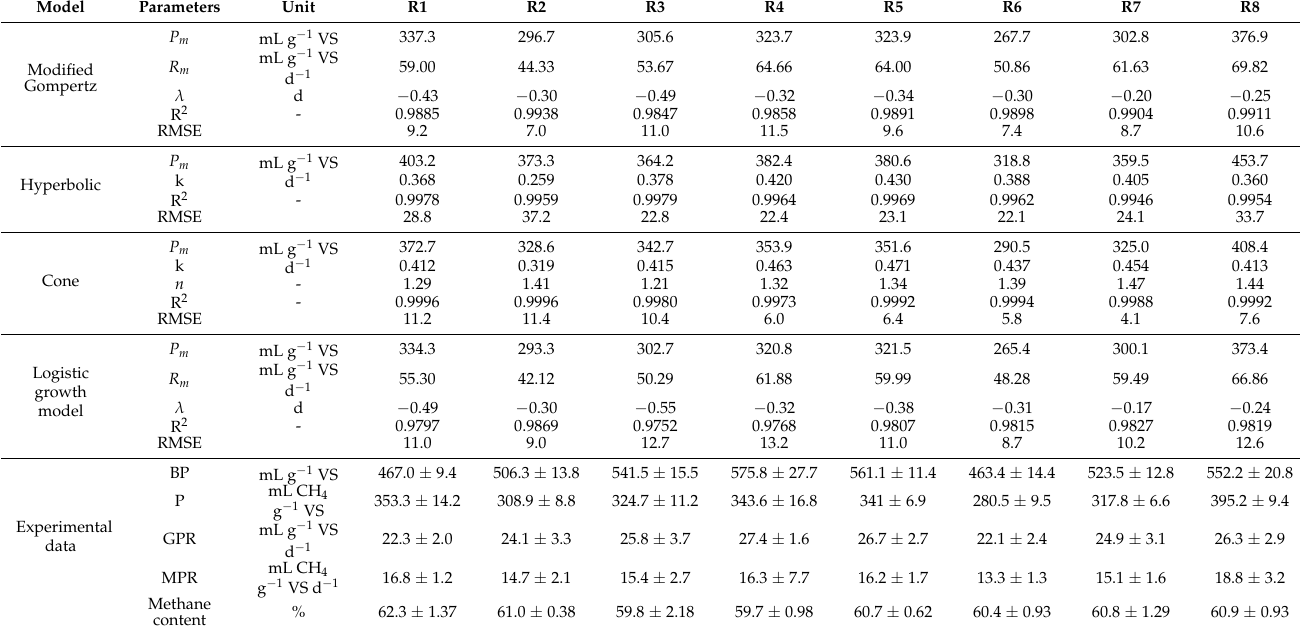
Table 4. The results of experimental data in terms of biogas/methane productions as well as estimated kinetic